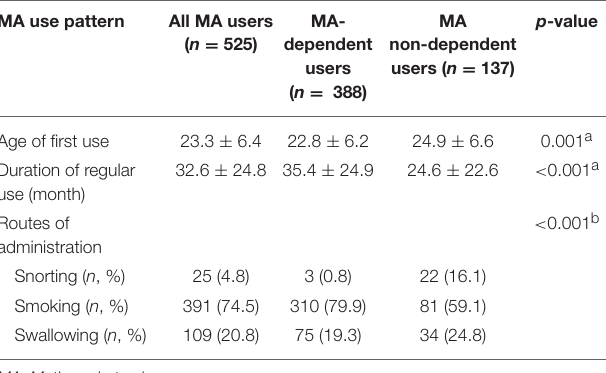
TABLE 2 | Methamphetamine (MA) use pattern of the study sample and group comparison between MA-dependent and non-dependent users. MA use pattern